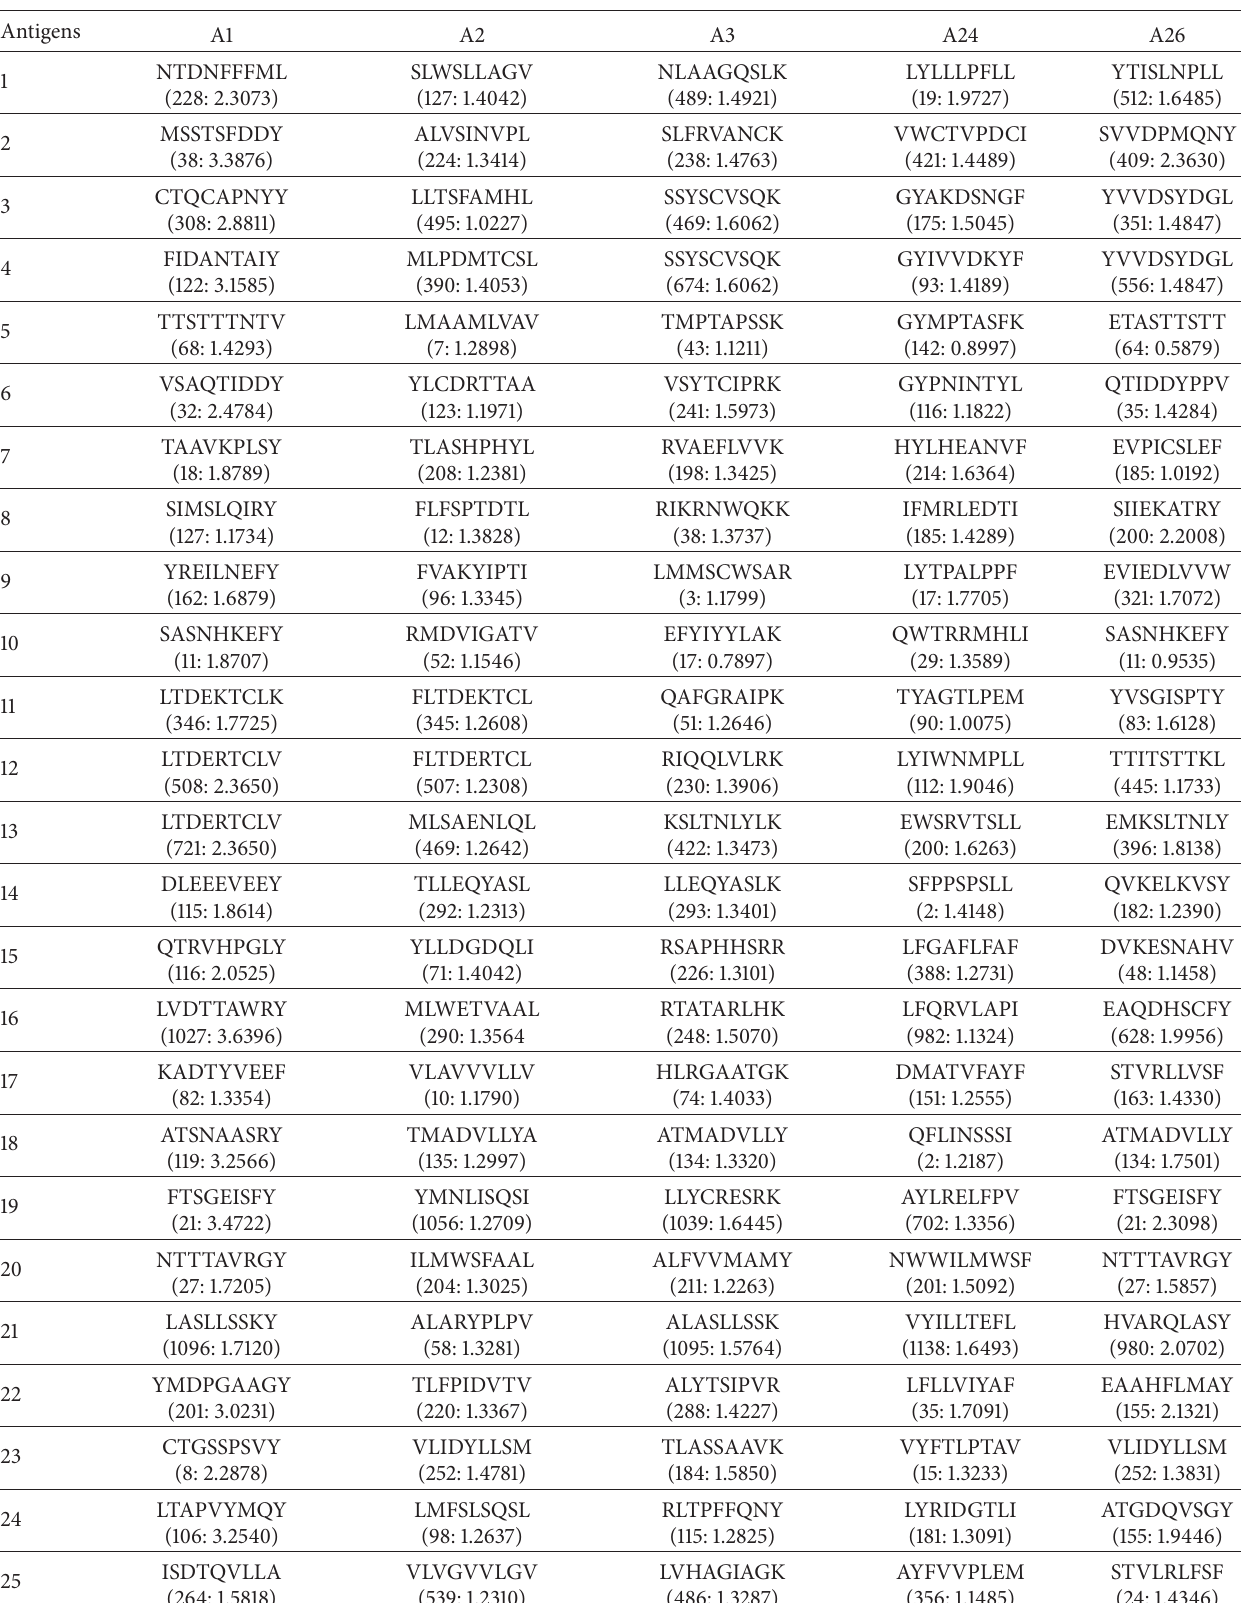
Table 2: NetCTL predicted top scoring CTL epitopes along with start position and processing score for the HLA-A supertypes in 25 L. major candidate